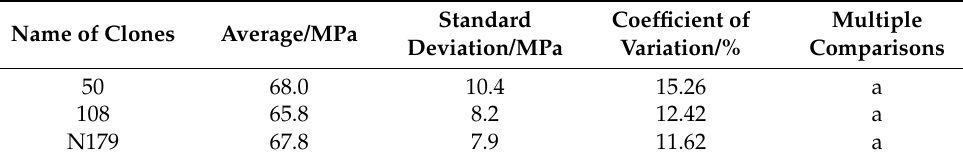
Figure 3. Radial variation of the physical and mechanical properties in three poplar clones. ( A ): air dry density; ( B ): modulus of rupture (MOR); ( C ): modulus of elasticity (MOE); ( D ): compressive strength parallel to grain. Table 3. Statistical results of MOR in three poplar clones. Table 3. Statistical results of MOR in three poplar clones.